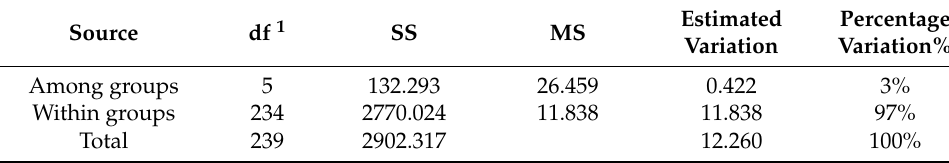
Table 2. Analysis of molecular variance (AMOVA) of 240 sweetpotato accessions based on InDel